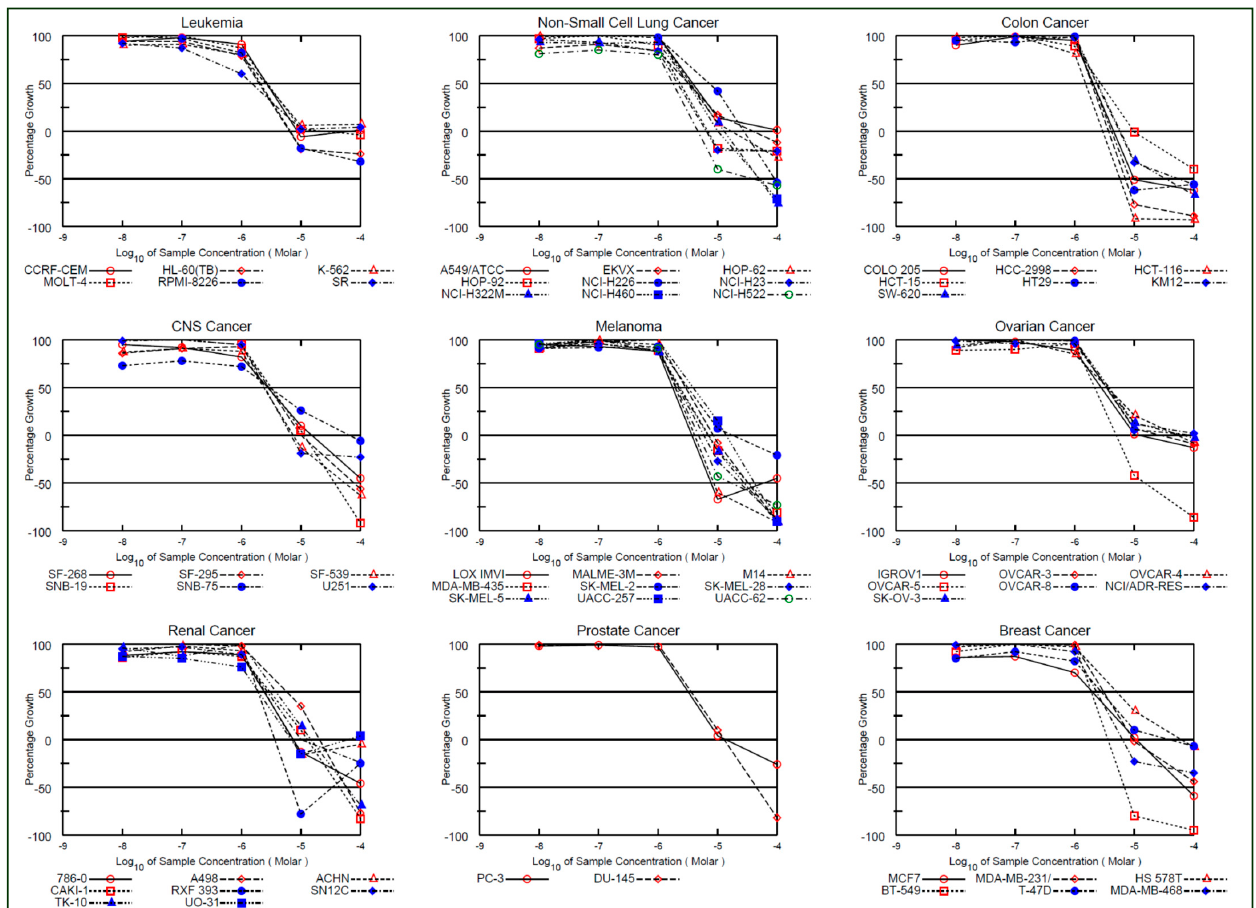
Figure 7. Antiproliferative profile of compound 3c in terms of GP and Log 10 molar concentration.